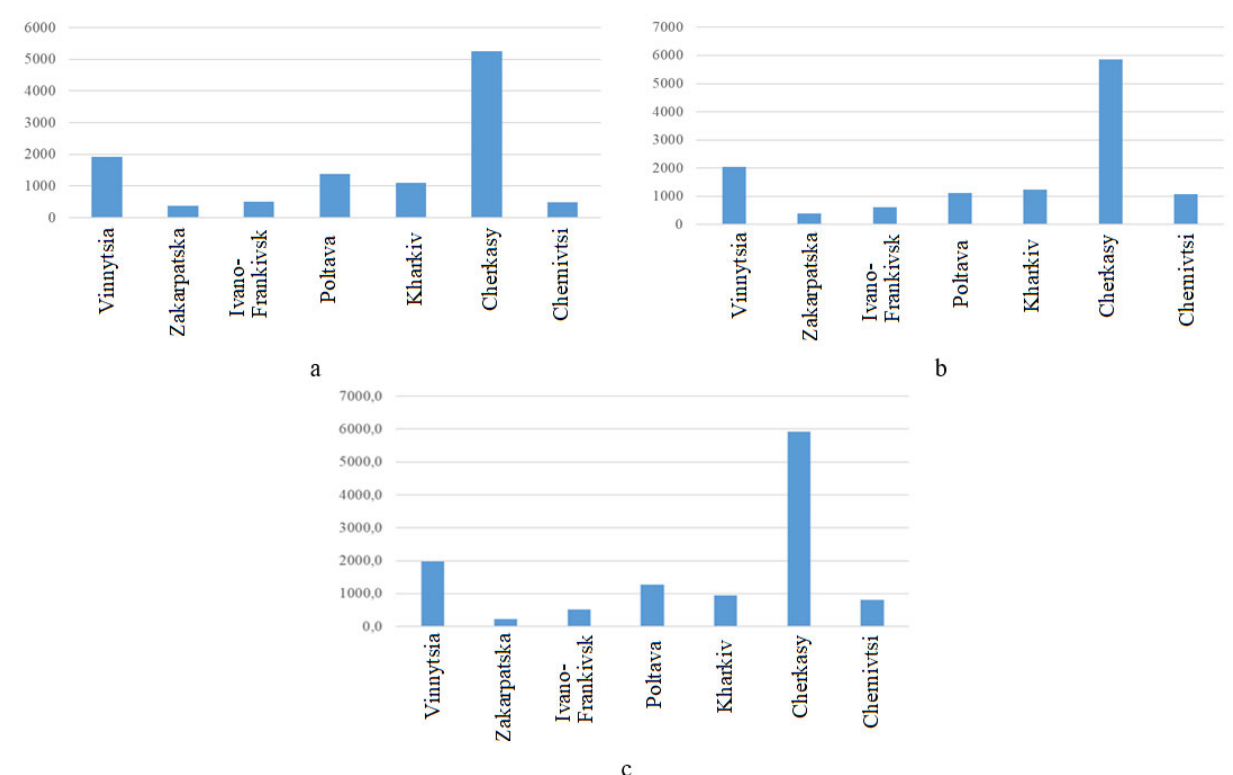
Fig. 4. Dynamics of catching aquatic organisms in inland waters, tons